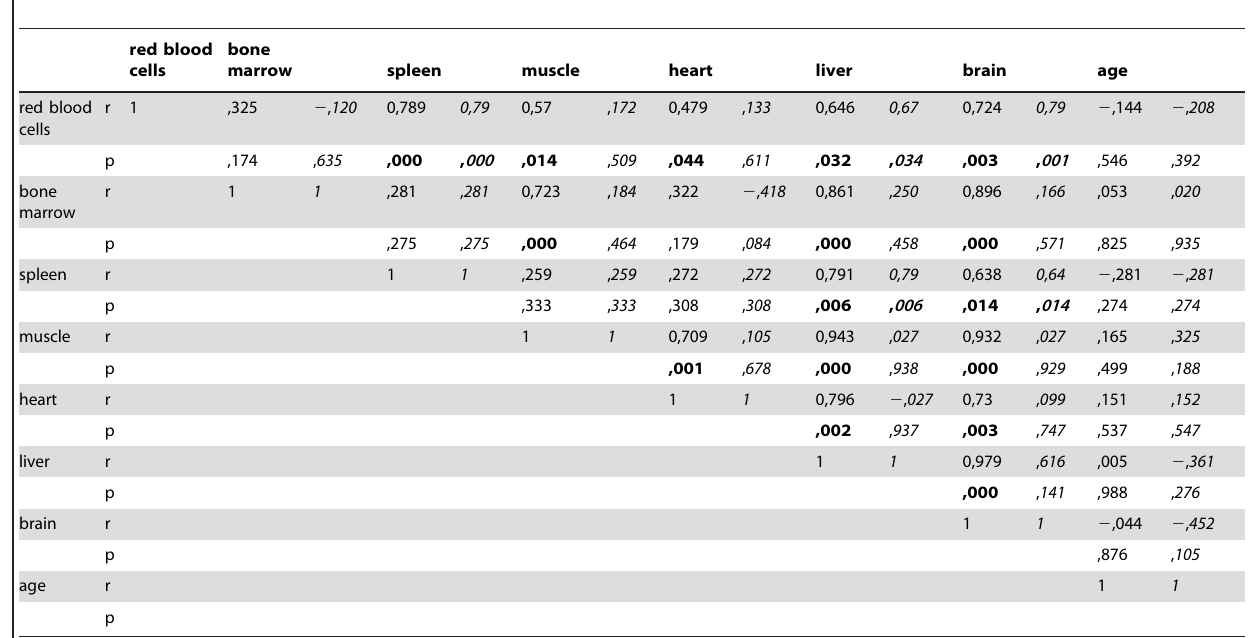
Table 2. Results of the Pearson’s correlations testing the linear relationships between telomere lengths in different tissues, as well as the relationships between telomere length and age in the different tissues (right